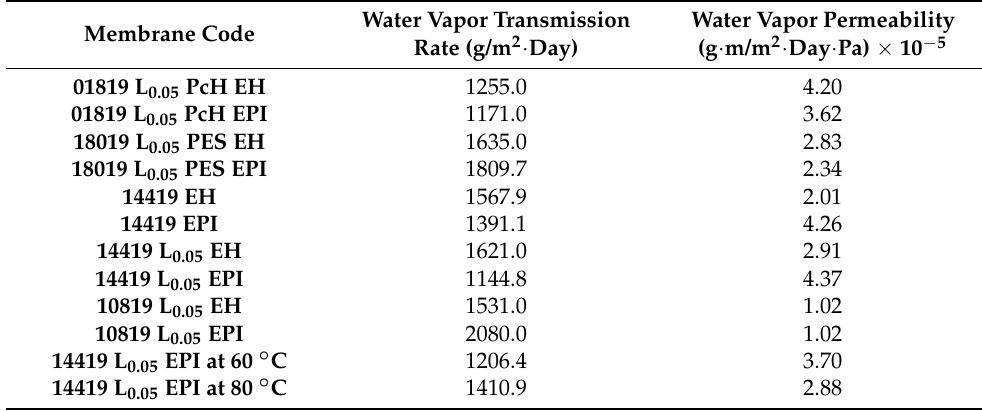
Table 4. Water vapor transmission rate (g/m 2 · day) and water vapor permeability (g · m/m 2 · day · Pa) of the prepared